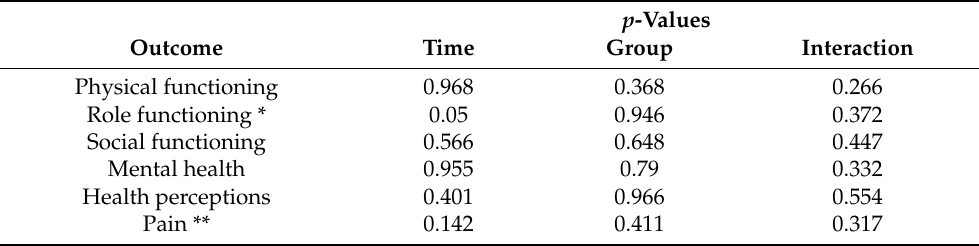
Table 6. Mixed ANOVA results examining changes in health-related quality of life from baseline to completion between groups.